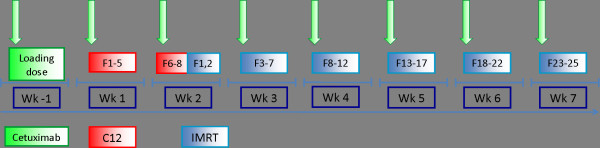
combined radioimmunotherapy schedule.